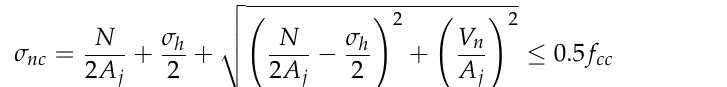
Figure 22. ACM-strengthened column.